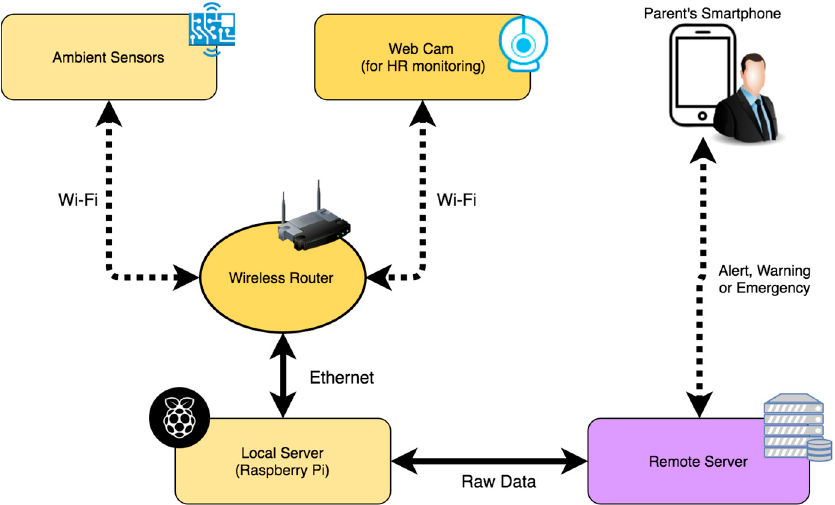
Figure 8. General diagram of the system.